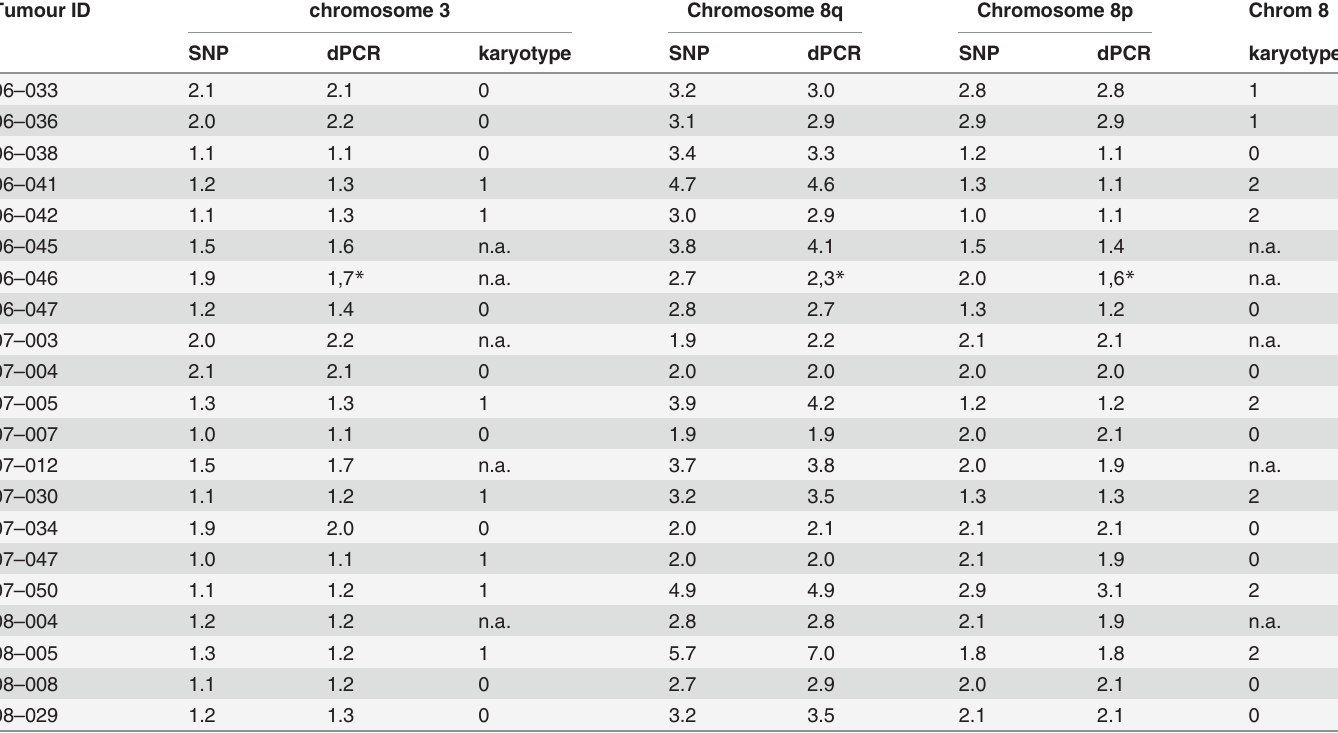
PLOS ONE | DOI:10.1371/journal.pone.0116371 March 12,